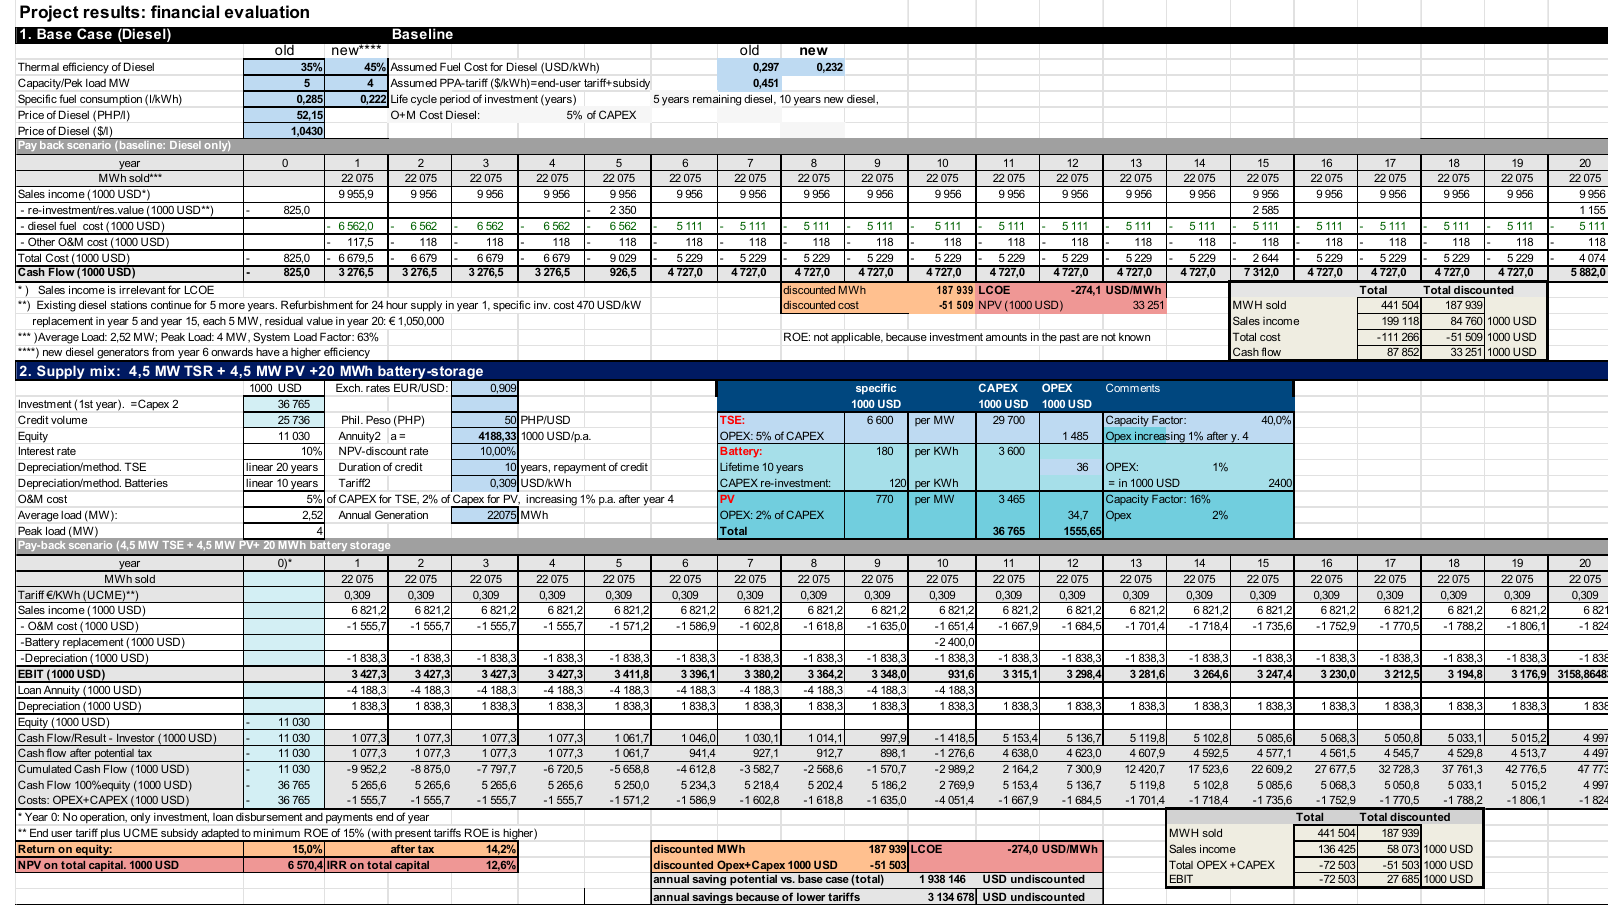
Figure A1. Project results.